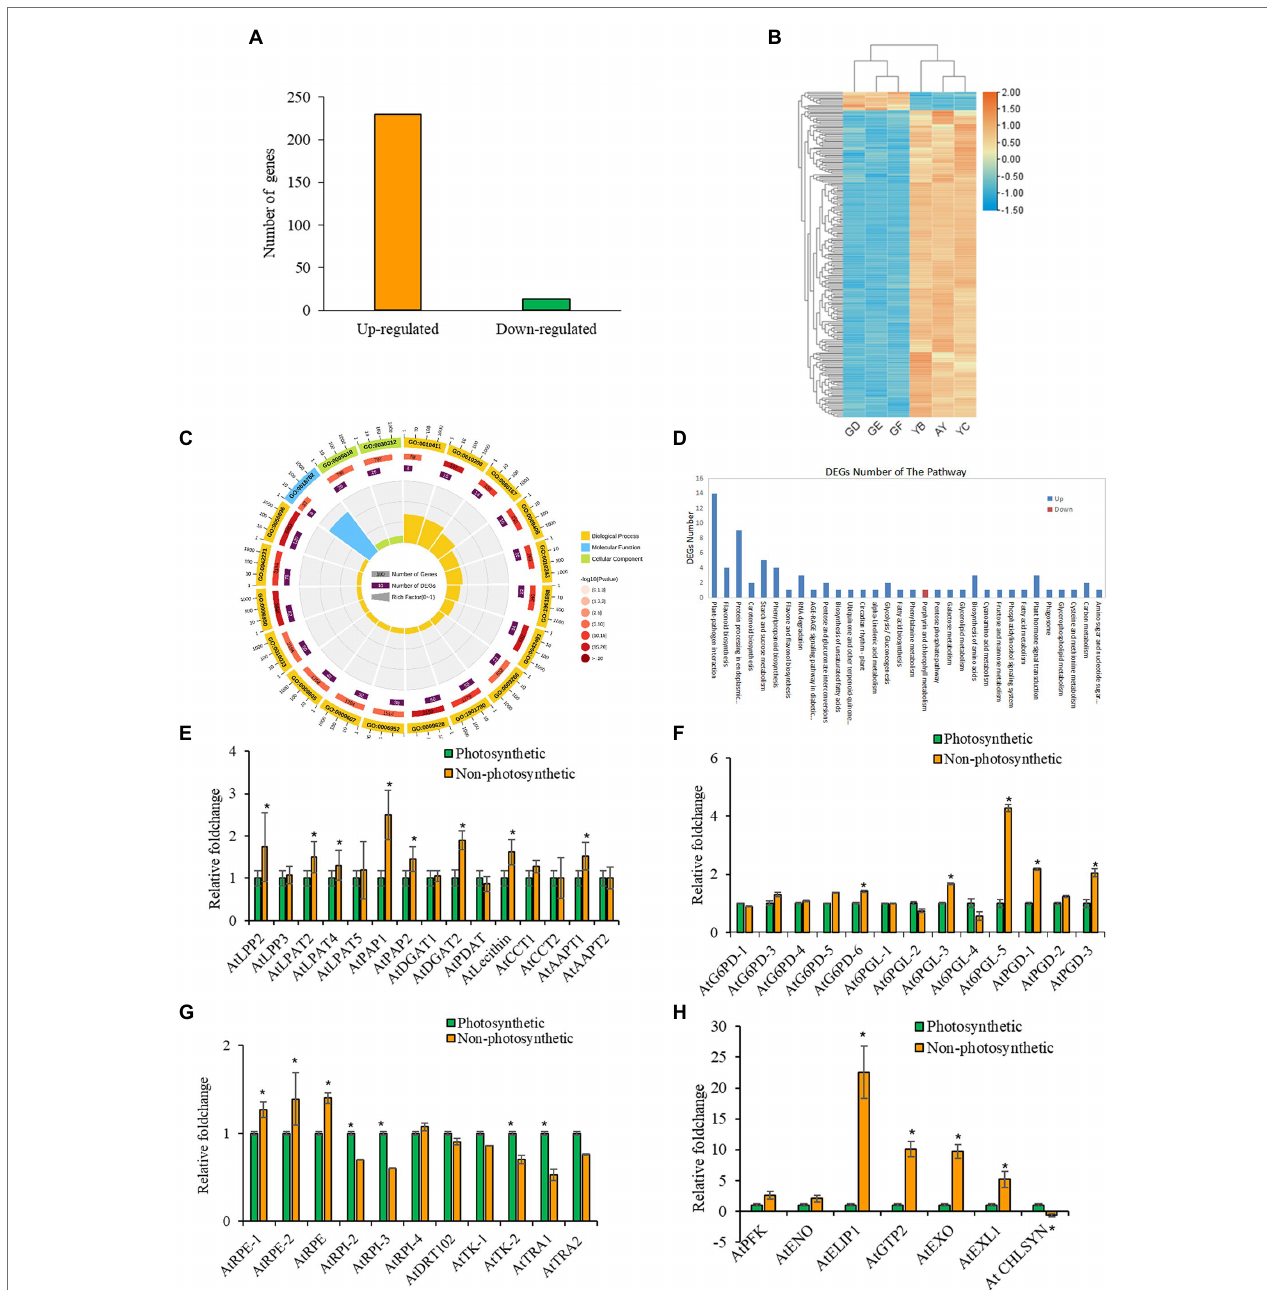
FIGURE 5 | Gene expression analysis of developing yellow and green seeds at 10 DAF. (A) Number of DEGs in the non-photosynthetic background. (B) Heat map showing expression profile of DEGs. (C) Showing the GO classification of DEGs in the non-photosynthetic background. (D) Differentially enrich pathways of DEGs in the non-photosynthetic background. (E) Real-time PCR analysis of TAG biosynthetic pathway genes. (F) Differentially expressed gene of the cytosolic and plastic branch of the oxidative pentose phosphate pathway. (G) Non-oxidative pentose phosphate pathway. (H) Sugar transport. Green and yellow bars indicate photosynthetic green seeds and non-photosynthetic seeds. Values are means ±SD ( n = 3 biological replicates, i.e., GD, GE, GF are three replicated biological samples belonging to green seeds. While YB, YA, YC are three replicated biological samples of yellow seeds). Statistical significance was analyzed using the two- sided Student t -test. The asterisk indicates a significant difference ( * p <